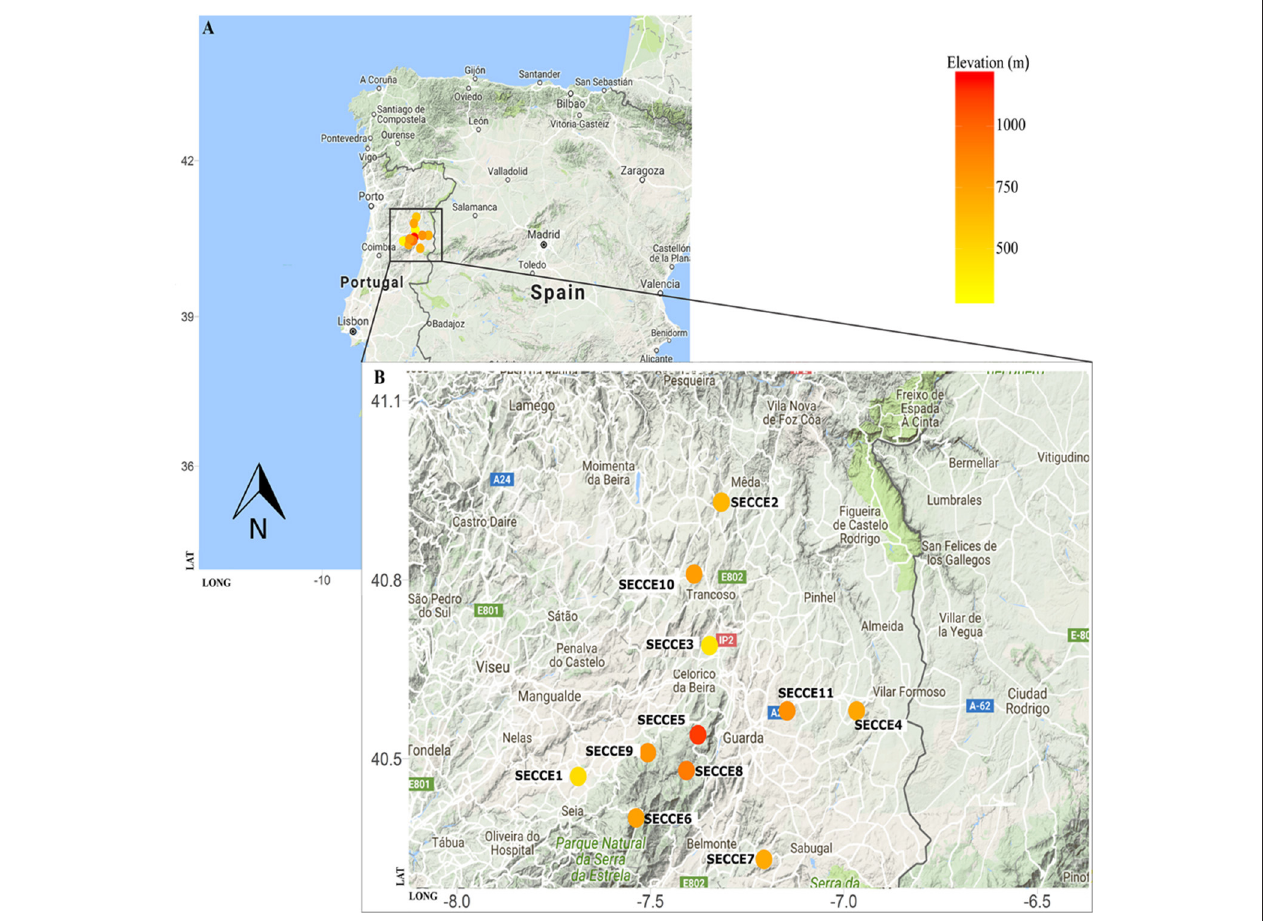
FIGURE 1 | Map of Portugal with region of rye sampling highlighted (A) and in situ populations detailed along an elevation gradient (B). Visualization was generated using R package ggmap and occurrence list according to elevation by rgbif package.